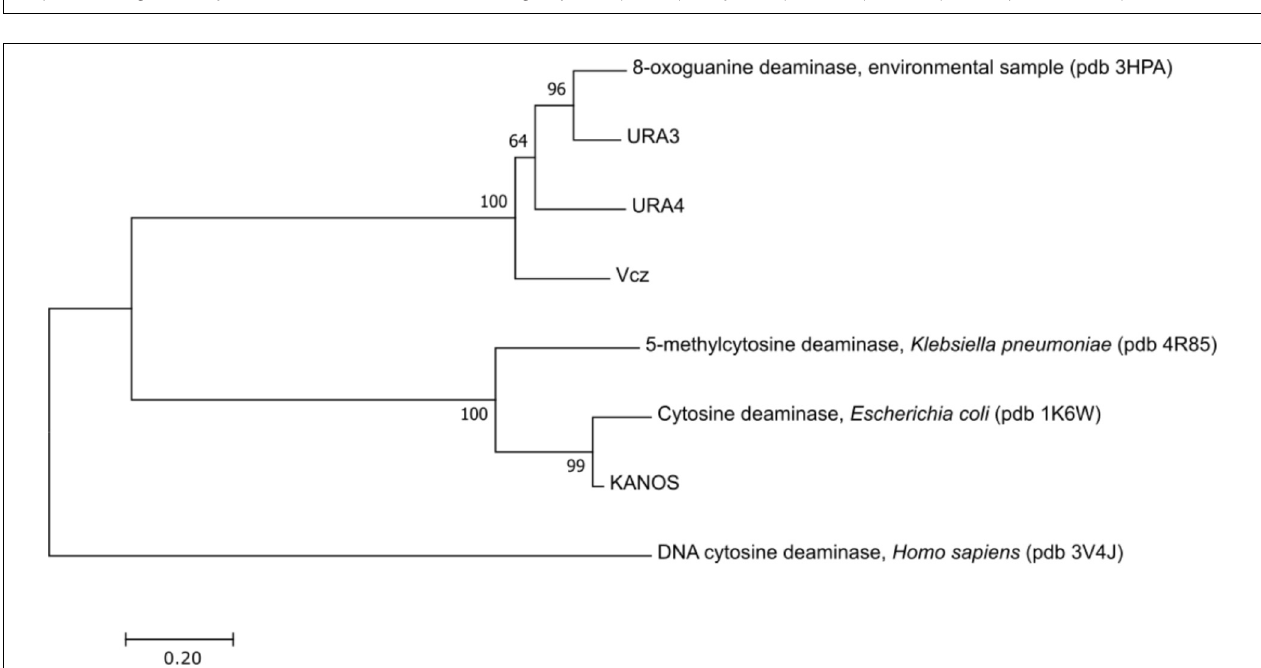
FIGURE 3 | Evolutionary relationships of deaminases. The evolutionary history was inferred using the Neighbor-Joining method (Saitou and Nei, 1987). The optimal tree with the sum of branch length = 3.9 is shown. The percentage of replicate trees in which the associated taxa clustered together in the bootstrap test (1000 replicates) are shown next to the branches (Felsenstein, 1985). The tree is drawn to scale, with branch lengths in the same units as those of the evolutionary distances used to infer the phylogenetic tree. The evolutionary distances were computed using the Poisson correction method (Zuckerkandl and Pauling, 1965) and are in the units of the number of amino acid substitutions per site. The analysis involved 8 amino acid sequences. All positions containing gaps and missing data were eliminated. There were a total of 207 positions in the final dataset. Evolutionary analyses were conducted in MEGA7 (Kumar et al., 2016). This analysis demonstrates that the enzymes found in metagenomic libraries belong to two groups as depicted in the tree: the classical cytosine deaminases (KANOS) and the 8-oxoguanine deaminases (URA3, URA4, and Vcz).